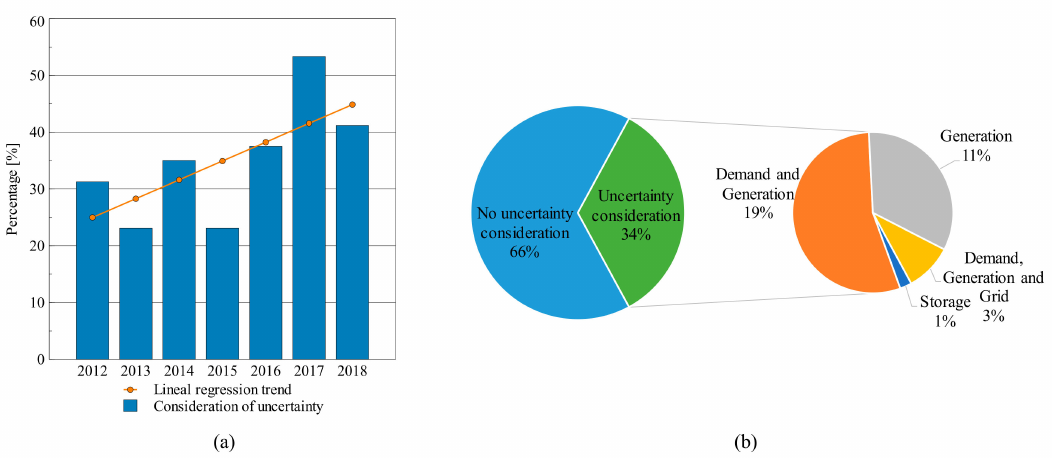
Figure 6. ( a ) Uncertainty trend in recent years, ( b ) Uncertainty consideration distribution in di ff erent microgrid